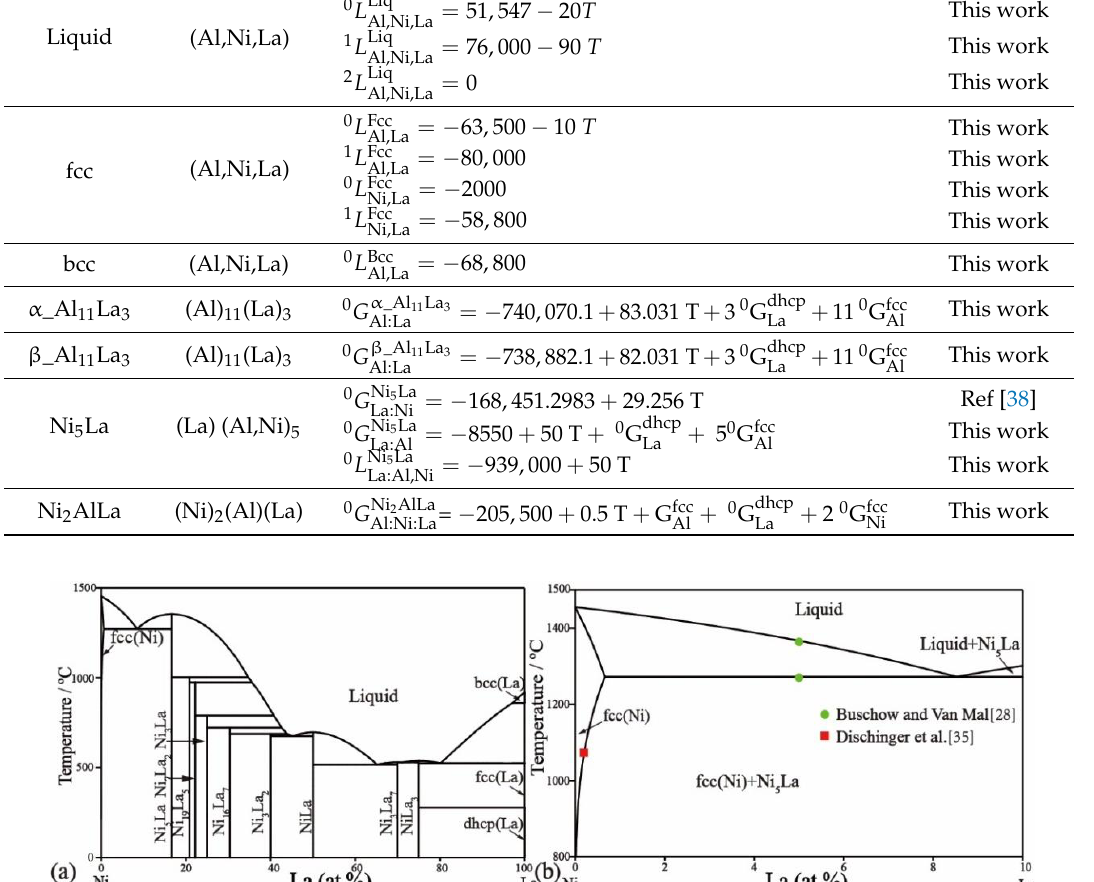
Figure 6. Calculated Ni–La phase diagram. ( a ) Full composition range, ( b ) magnified Ni-rich corner showing solubility of La in fcc(Ni).